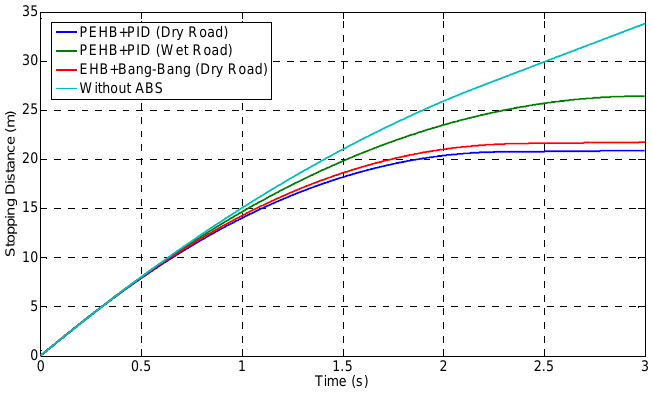
Figure 24. Comparison of various braking distances.